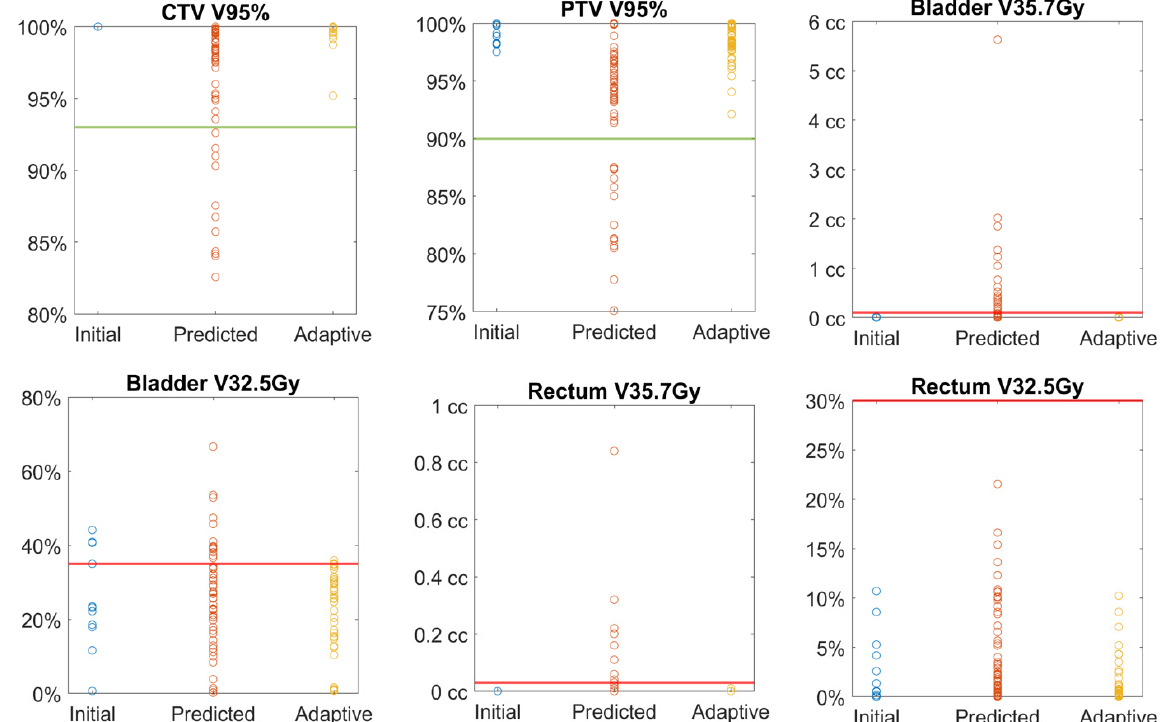
Figure 2. Comparison of target and OAR dosimetric metrics between initial, predicted and adaptive plan doses. The line in each plot represents the acceptable criterion. Bladder and rectum maximum doses are presented by V35.7 Gy < 0.03 cc.